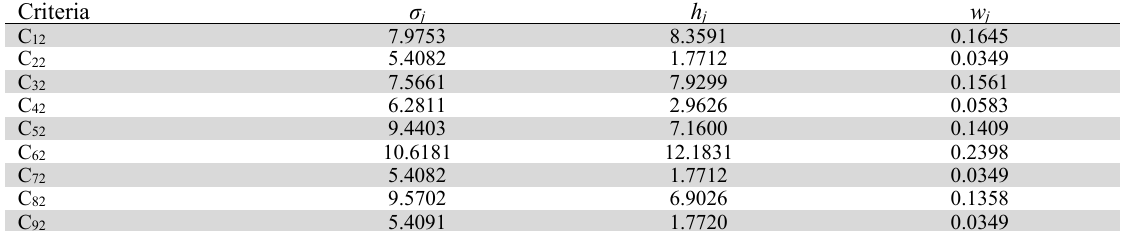
CRITIC method outputs for the economic criteria